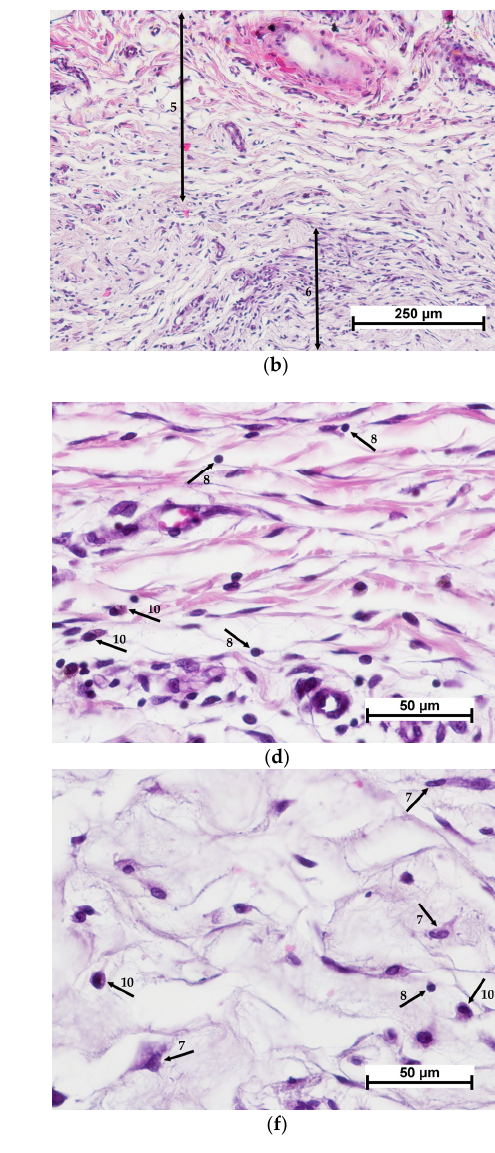
Figure 6. Histological picture—day 21. Comparison of cell-free scaffold ( a , c ) and collagen matrix ( b , d ). ( a , b )—implant site with surrounding tissue, general view, ( c , d )—connective tissue structure at the implant site. Staining with hematoxylin–eosin.